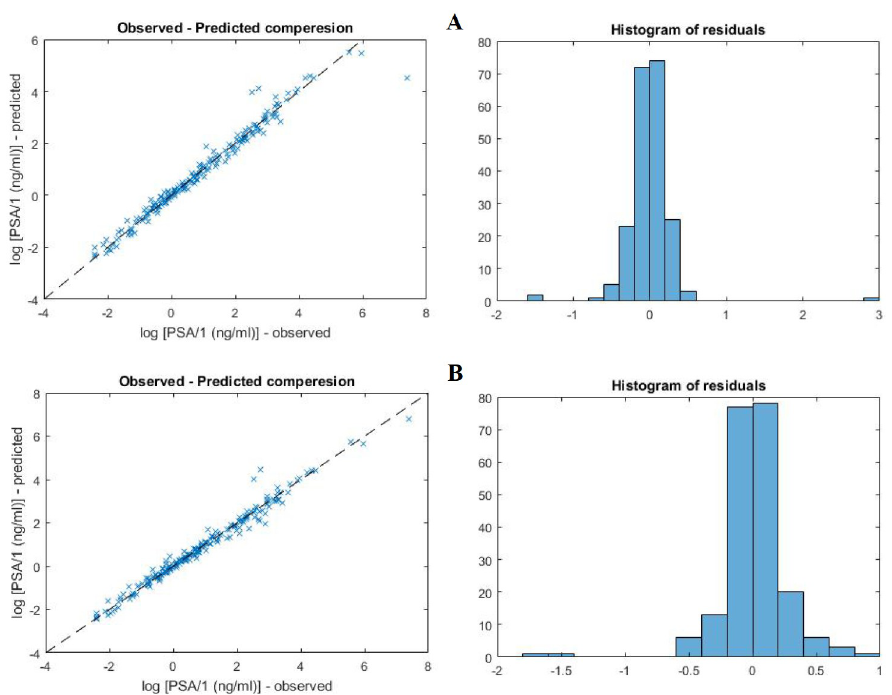
Fig 3. Comparison between the fits obtained for the growth law proposed in this paper (panel A) with per capita growth rate described by Eq (2) and the model proposed in [11] (panel B).